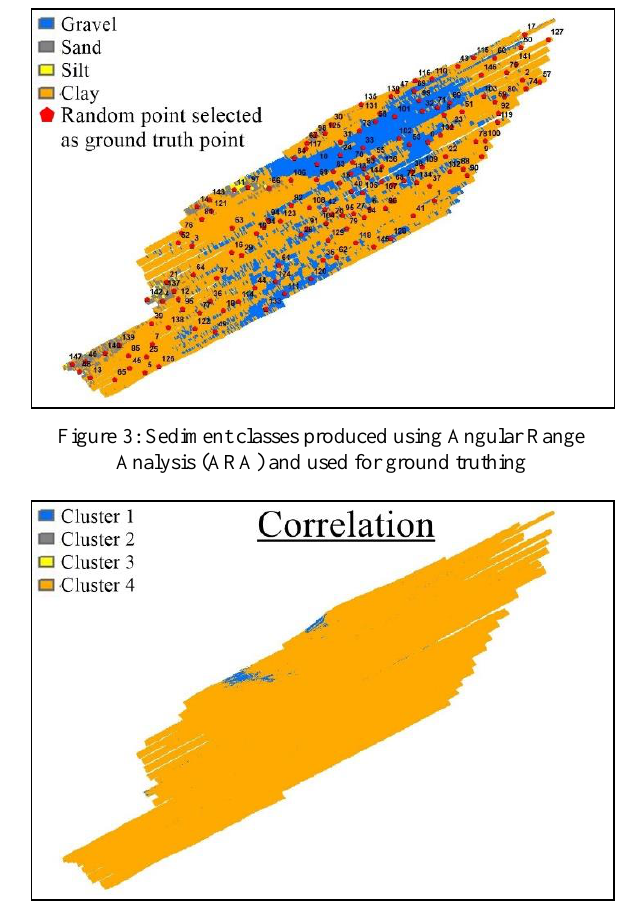
Figure 4: GLCM Correlation Cluster Map